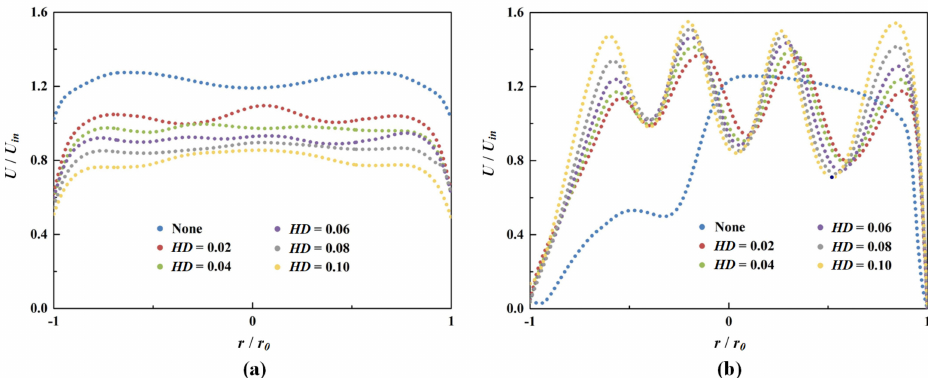
Figure 15. Velocity distribution of ( a ) horizontal and ( b ) vertical centerline of 0.67 D cross − section downstream of 90 ◦ bend pipe with different thick − diameter ratio deflectors installed.